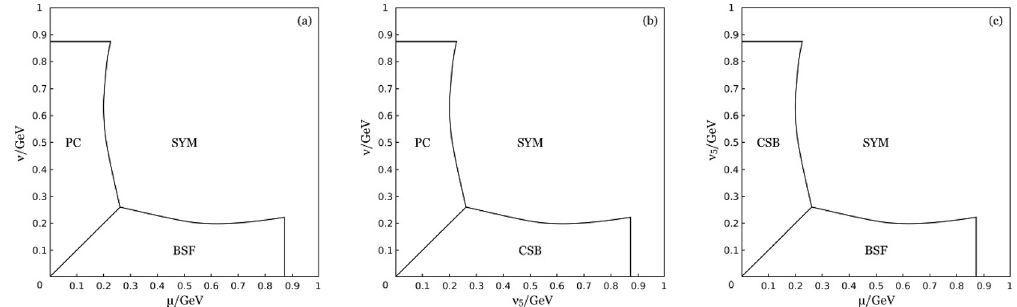
Figure 1 . (a) ( (cid:22); (cid:23) )-phase diagram at (cid:23) 5 = 0. (b) ( (cid:23) 5 ; (cid:23) )-phase diagram at (cid:22) = 0. It is dually D 2 conjugated to a diagram of (cid:12)gure 1(a). (c) ( (cid:22); (cid:23) 5 )-phase diagram at (cid:23) = 0. It is dually D 3 conjugated to a diagram of (cid:12)gure 1(a). In all panels BSF means the baryon super(cid:13)uid (or diquark condensation) phase in which M = 0, (cid:25) 1 = 0, j (cid:1) j 6 = 0. PC is the shorthand for the charged pion condensation phase with M = 0, (cid:25) 1 6 = 0, j (cid:1) j = 0. In the chiral symmetry breaking (CSB) phase M 6 = 0, (cid:25) 1 = 0, j (cid:1) j = 0. SYM is the notation for the symmetrical phase, where M = 0, (cid:25) 1 = 0, j (cid:1) j =